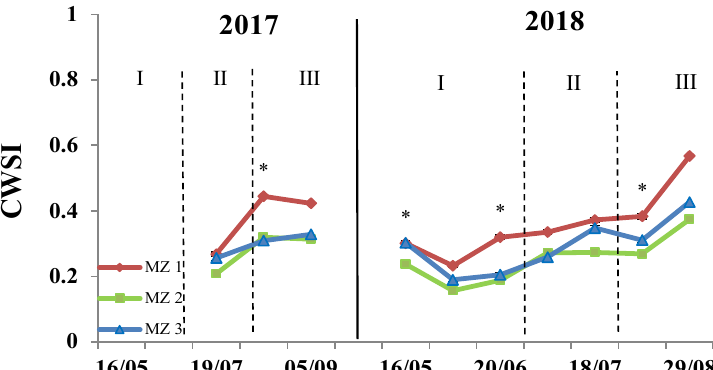
Figure 11. Seasonal course of crop water stress index (CWSI) of vines in the management zones during 2017 and 2018. Each point is the mean of 2031, 2126 and 1364 vine polygons for MZ 1, 2 and 3, respectively ± SE. The value of each replicate was the average of the lowest 33% of vine’s polygon. Asterisks represent significant differences among MZs using ANOVA ( α = 0.05).